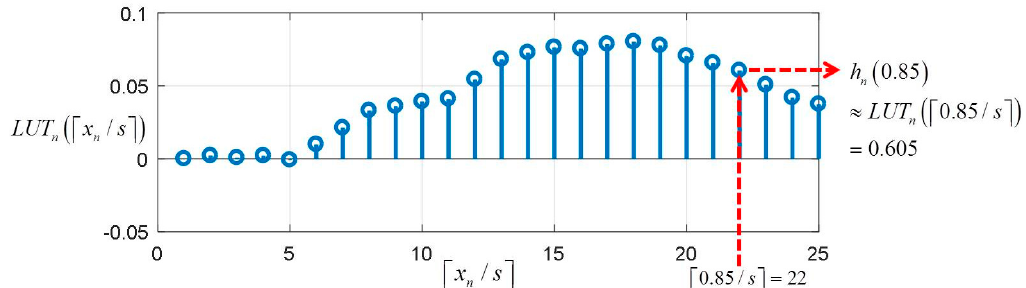
Figure 13. Example of retrieving value of h n ( x n ) from LUT n for x n = 0.85.